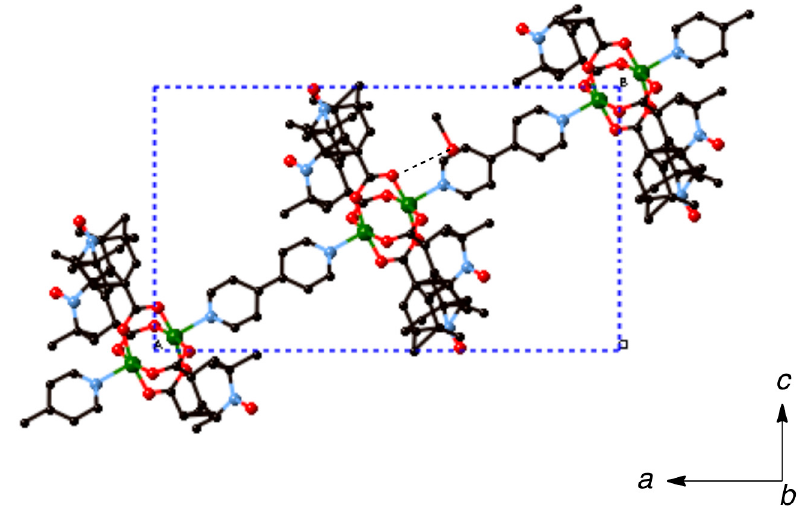
Figure 8. Perspective view of chain molecule for [Cu 2 (catempo) 4 (4,4 ′ -bpy)] n ( 9 ). Hydrogen atoms are omitted for clarity.